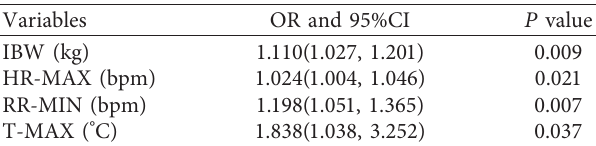
Table 2: Multivariate analysis of the risk factors for noninvasive ventilation failure.